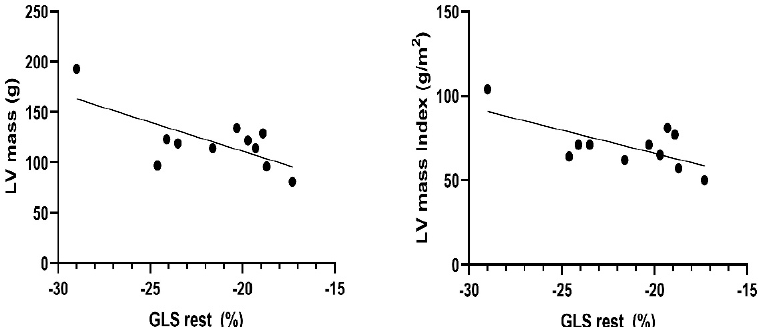
Figure 2. Negative correlation between LV mass and LV mass Index and LV-GLS at rest in world elite Ski-Mo professionals.